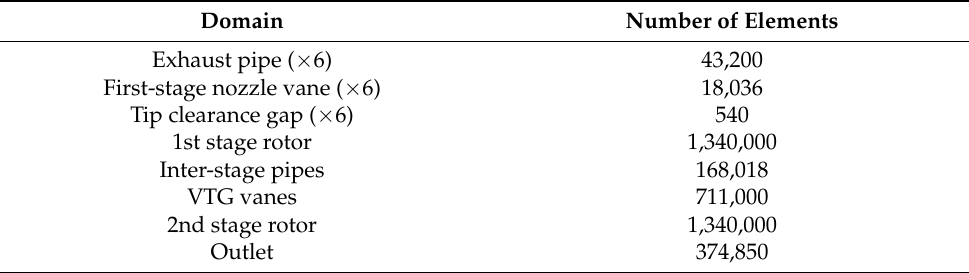
Table 5. The number of cells for each